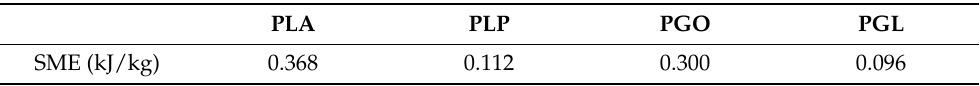
Table 5. Specific mechanical energy values for PLA, PLP, PGO, and